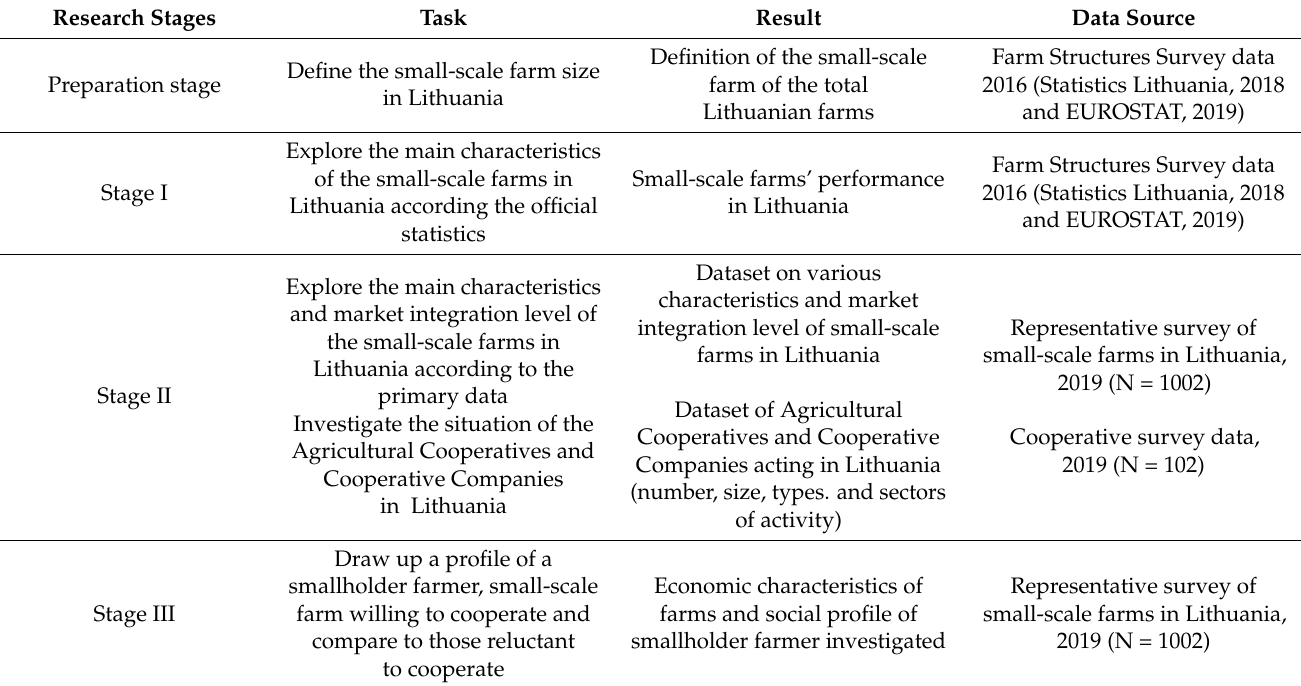
Table 1. Research stages, main tasks, results, and data